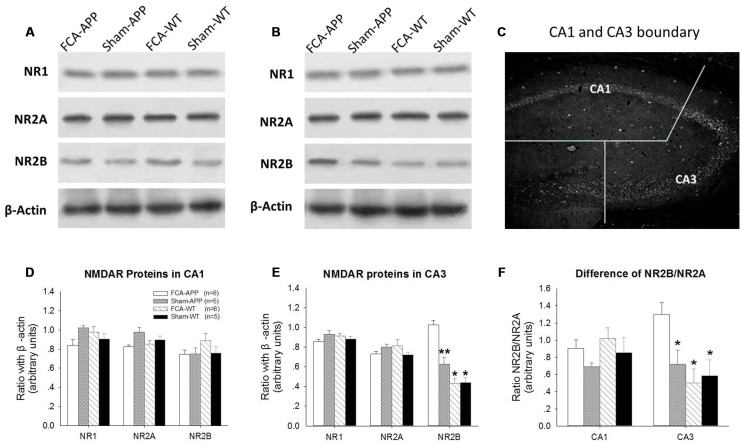
NR2B protein and ratio of NR2B/NR2A significantly increase in CA3 tissue obtained from APP/PS1 transgenic animals with chronic monoarthritis pain. Western blotting analysis was performed to quantify NR1, NR2A and NR2B protein expression in hippocampus CA1 and CA3 of APP/PS1 transgenic animals and WT animals with or without chronic monoarthritis pain. (A) Representative images of NR1, NR2A, NR2B and β-actin in CA1. (B) Representative images of NR1, NR2A, NR2B and β-actin in CA3. (C) Schematic illustration of the dissection procedure used for regional analyses. (D,E) Quantitative analysis revealed no significant difference in NR1, NR2A and NR2B protein expression in CA1 among the four groups. (E) Quantitative analysis revealed no significant difference in NR1 and NR2A in the CA3 among the four groups, but markedly increased NR2B protein expression in CA3 of APP/PS1 transgenic animals with chronic monoarthritis pain. (F) No significant difference is detected in the ratio of NR2B/NR2A in the CA1 among the four groups, but the NR2B/NR2A ratio in the CA3 of APP/PS1 transgenic animals with chronic monoarthritis pain markedly increases. *p < 0.001, **p < 0.05 compared to FCA-APP. Data are presented as the mean ± SEM. FCA-APP (n = 6), Sham-APP (n = 6), FCA-WT (n = 5) and Sham-WT (n = 5).